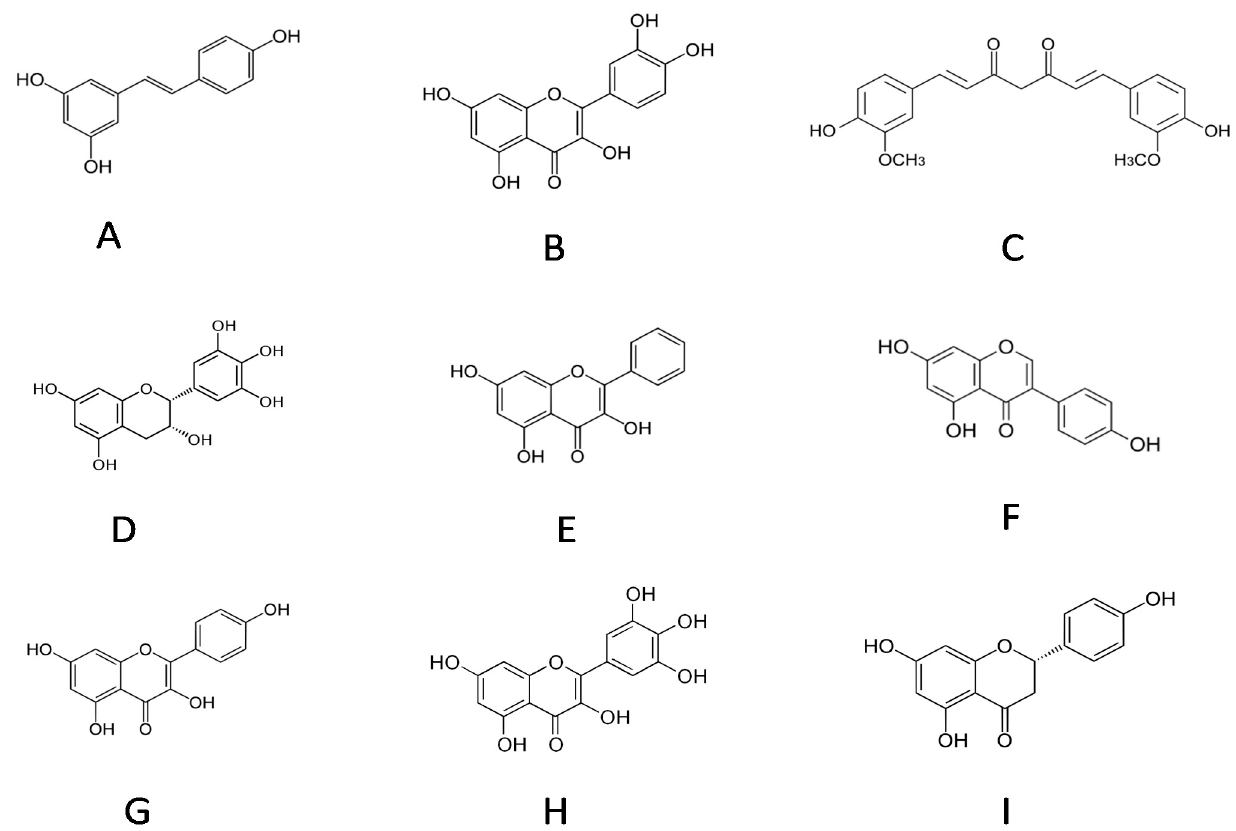
Figure 1. ( A ) resveratrol; ( B ) quercetin; ( C ) curcumin; ( D ) epigallocatechin; ( E ) galangin; ( F ) genistein; ( G ) kaempferol; ( H ) myricetin; ( I )